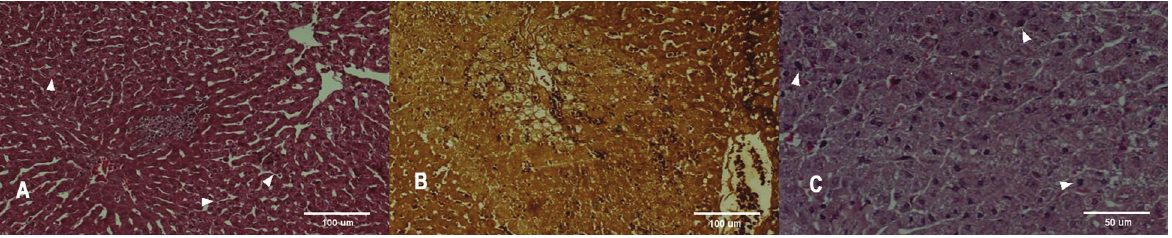
Figure 3. A , Focal vacuolar degeneration in ischemic preconditioning group (marked with arrowheads) (hematoxylin and eosin). B , Necrobiosis in the central part of the image in adenosine group (reticulin). C , Regeneration zone: hepatocytes with hyperchromic nuclei in adenosine group rabbit (marked with arrowheads) (hematoxylin and